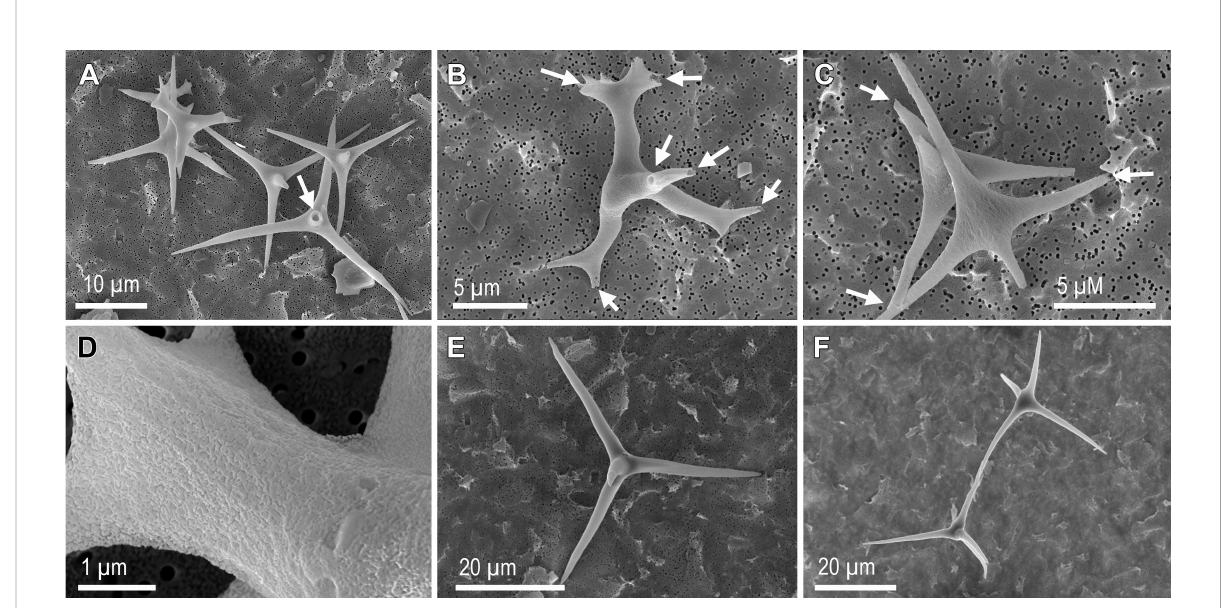
FIGURE 5 Scanning electron microscopy images of sponge skeletal pieces of the homoscleromorph Corticium candelabrum after 6 h and 24 h in 1% sodium carbonate at 85°C. Many of the microspicules were still present after 6 h (A – C) . However, they all showed substantial dissolution at their tips and inside (arrows), as well as at their surface (D) , revealing a surface etching pattern different from that in demosponges and hexactinellids. After 24 h, very few spicules remained undissolved (E, F) , being unclear the reasons for the resistance of such few spicules, given than they are similar in shape and structure to their dissolved